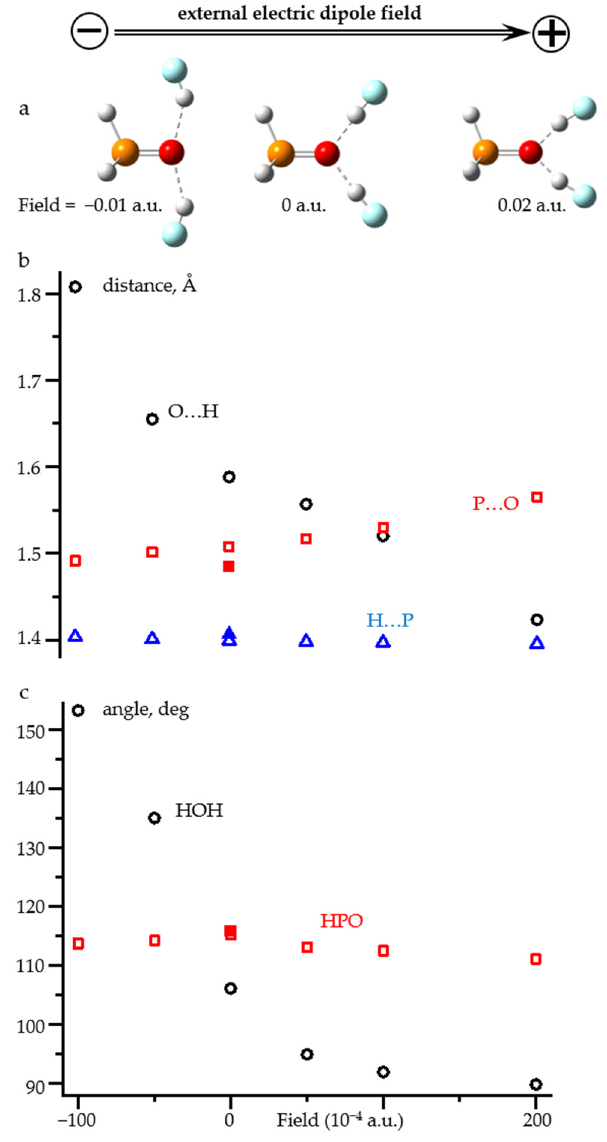
Figure 9. ( a ) Qualitative changes of the structure of H 3 P=O . . . (H-F) 2 complex under the action of an external electric field directed along the P=O bond. ( b ) The O . . . H (open black circles), P=O (open red squares), and H-P (open blue triangles) distances as functions of the field. ( c ) The HOH (open black circles) and HPO (open red squares) angles as functions of the field. The geometric parameters of free H 3 P=O are shown by filled symbols.